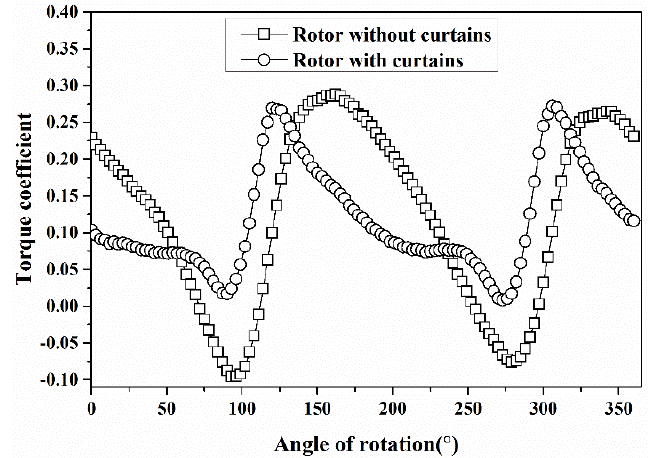
Figure 3. Comparison of torque coefficient between the schemes with and without curtains.